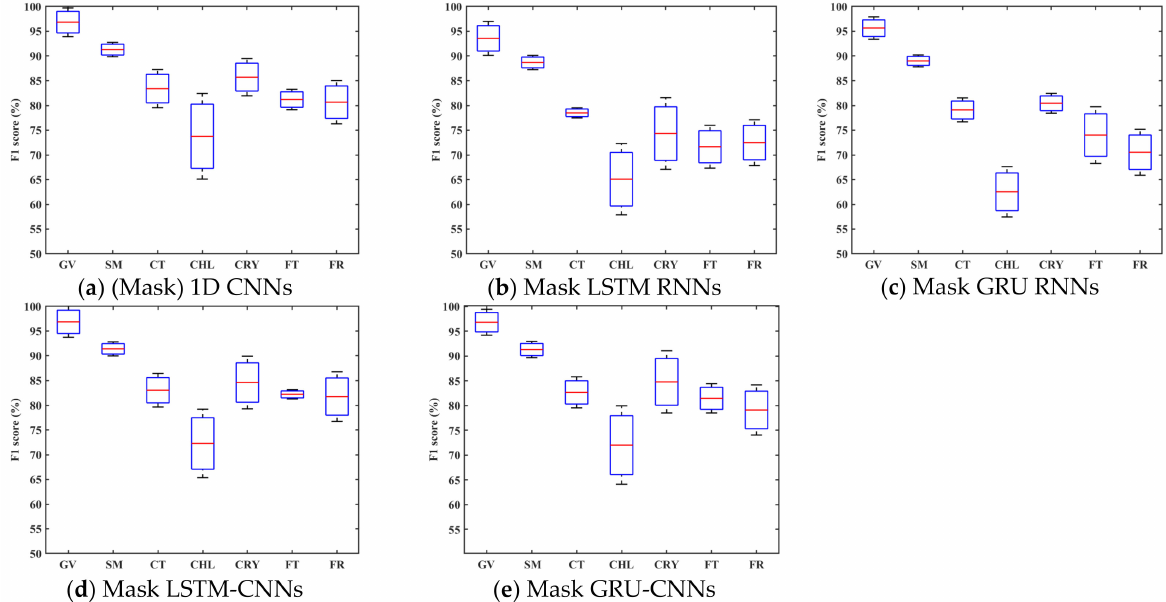
Figure 9. ( a – e ) The average F1 scores and standard deviations (from five split test sets) of each crop type with five types of networks using unfilled Sentinel-2 time series data. VG, vegetable greenhouse; SM, summer maize; CT, cotton; CHL, chili; CYR, common yam rhizome; FT, fruit trees; FR,